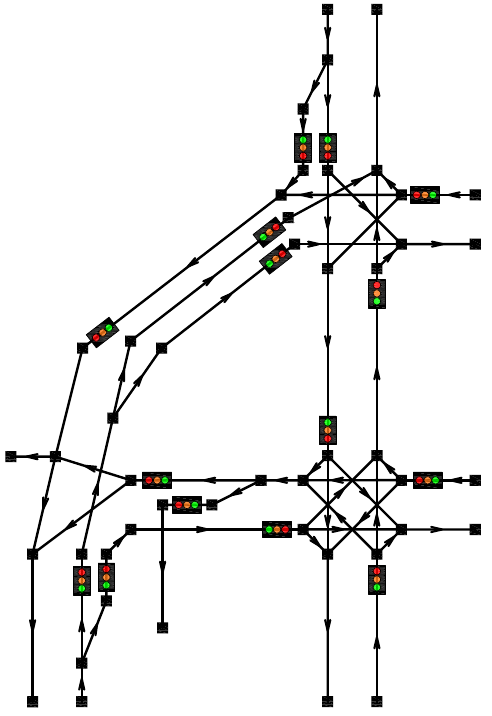
Figure 6. Second example: real traffic scenario, Brno, Czech Republic.